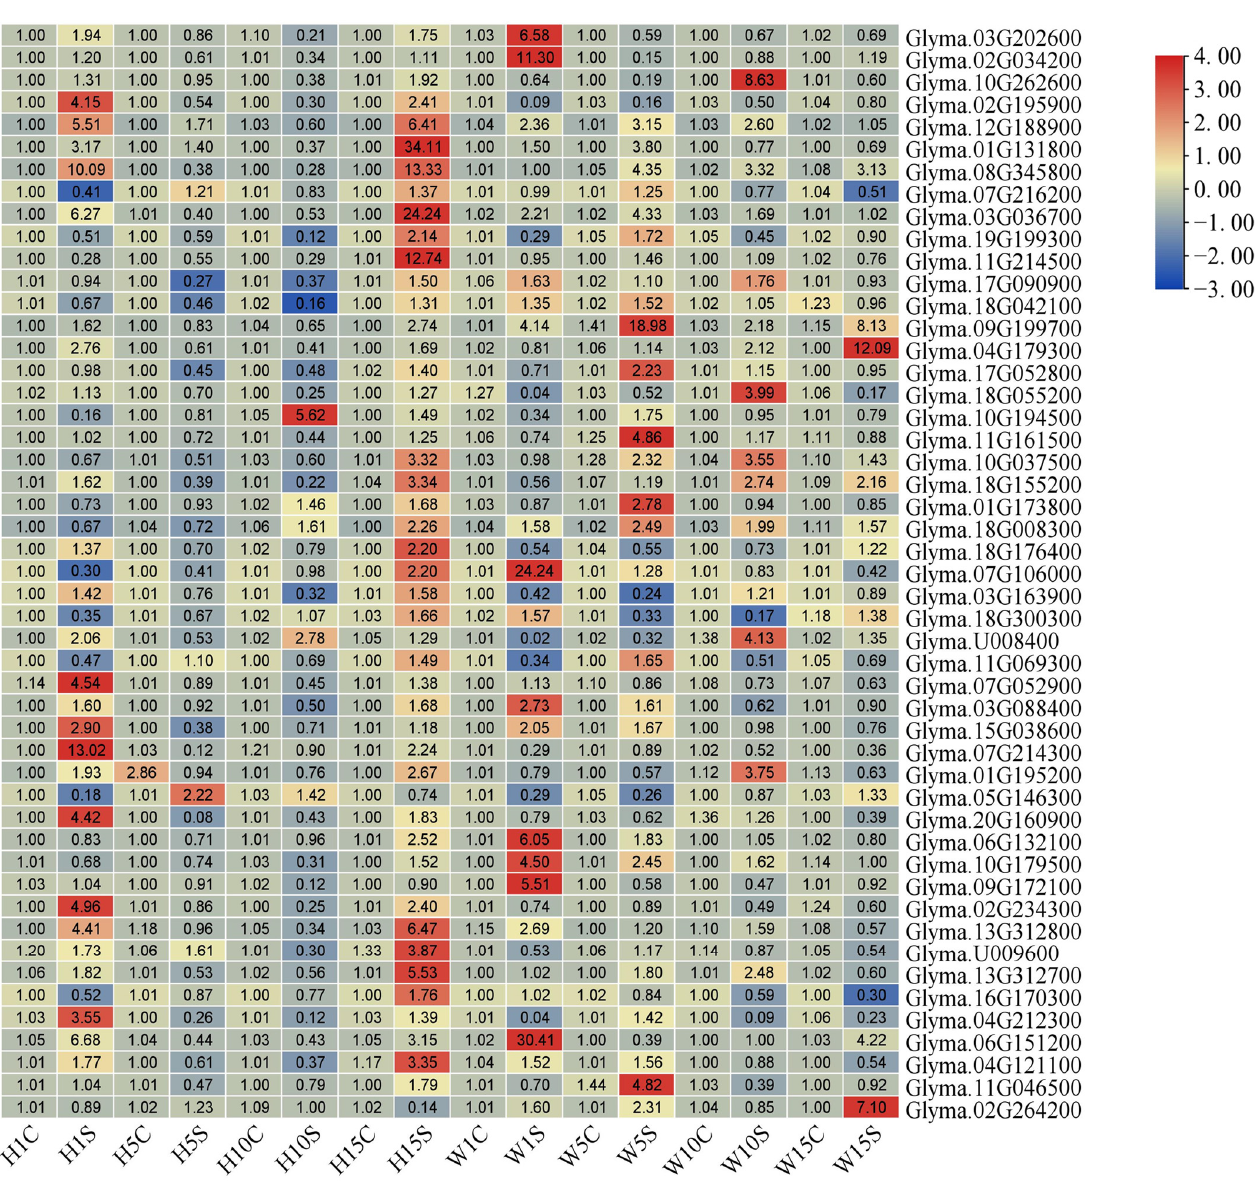
Figure 3. The heatmap of GmPUBs’ expression level of susceptible cultivar Williams 82 and resistant cultivar HPZ during soybean cyst nematode infection. Note: H1C and W1C represent the expressions of GmPUBs without soybean cyst nematode infect at 1 dpi, respectively. H1S and W1S represent the relative expressions of GmPUBs after soybean cyst nematode infection at 1 dpi, respectively. Likewise, the samples of H5C, W5C, H5S and W5S were taken at 5 dpi. The samples of H10C, W10C, H10S and W10S were taken at 10 dpi. Additionally, the samples of H15C, W15C, H15S and W15S were taken at 15 dpi. The relative expression value of GmPUBs higher than 1 and lower than 1 represent upregulation and downregulation,